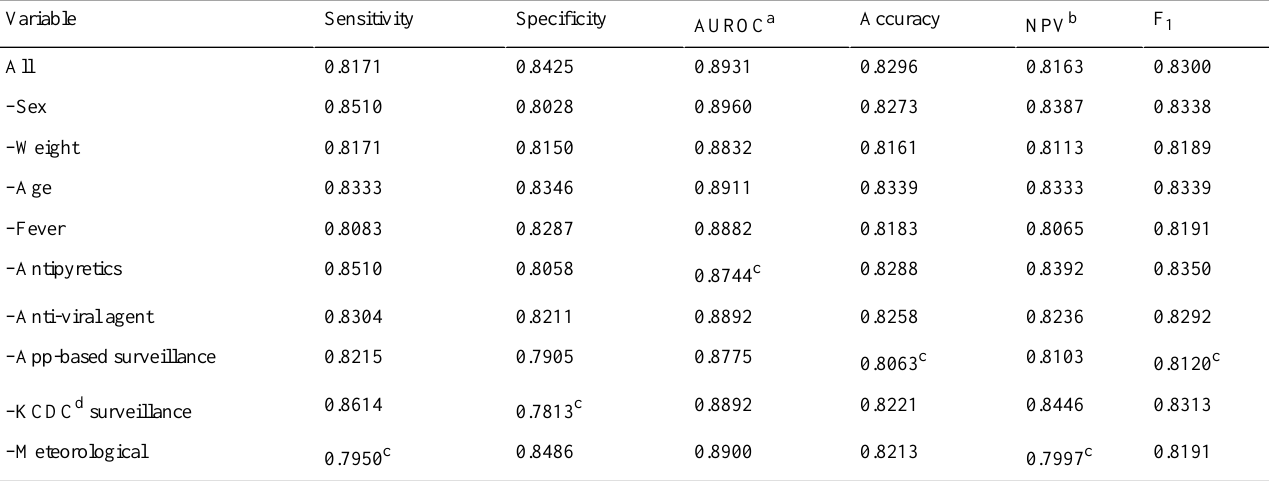
Table 3. The effects of the removal of each variable from the analysis. “–<Variable>” means that the variable was singularly removed from the list of variables for the corresponding